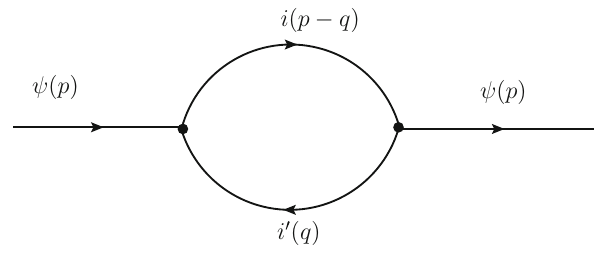
Fig. 3 The ψ propagator dressed with a i i (cid:5)